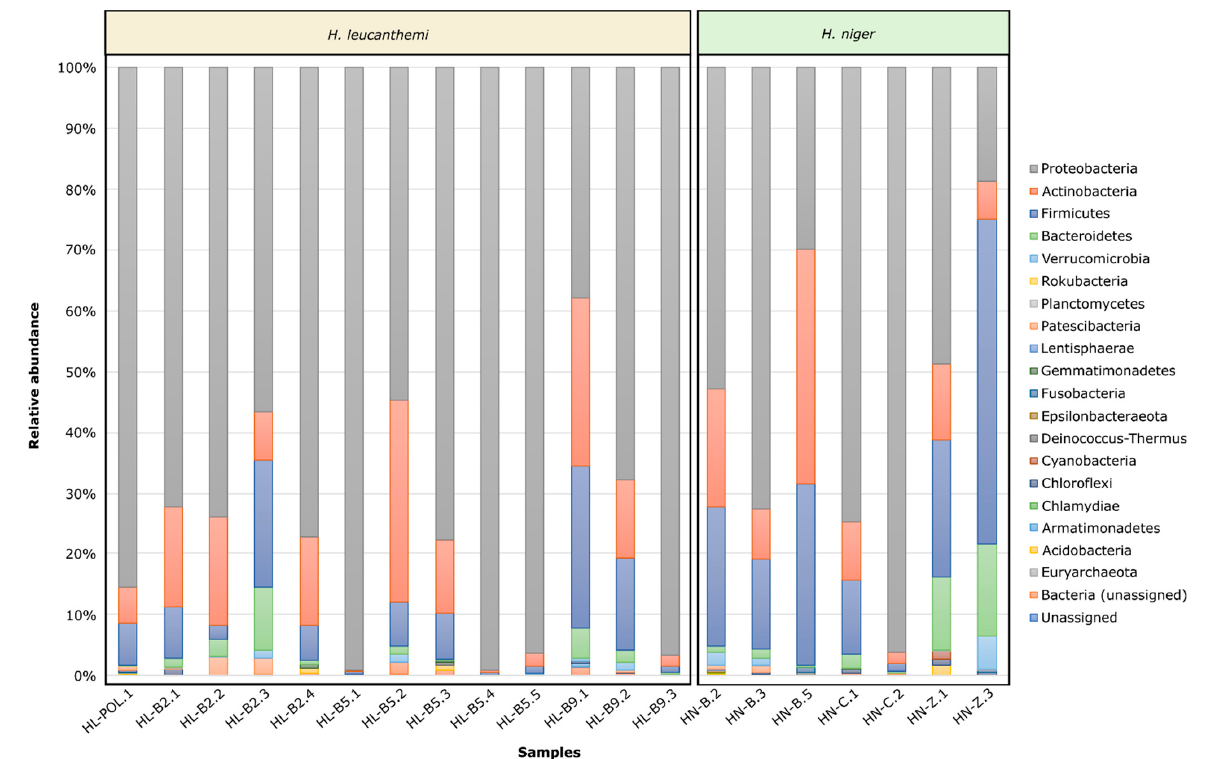
Figure 3. Phyla identified in profiles of microbial communities associated with tested Haplothrips leucanthemi and H. niger individuals.